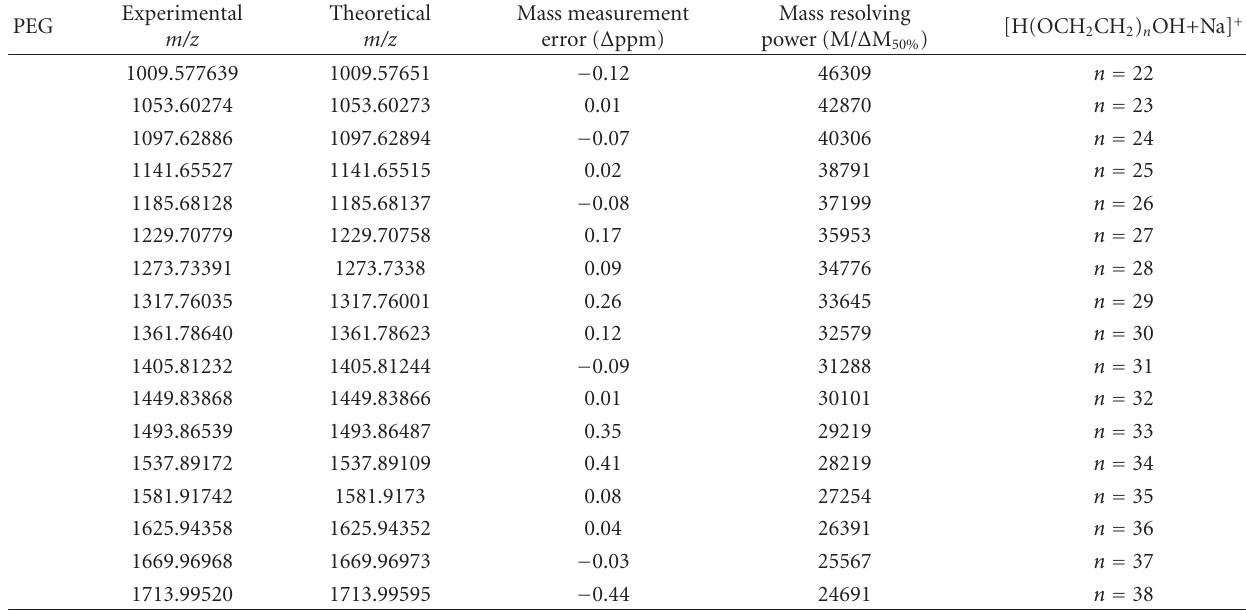
Table 1: PEG standards identified using paper spray mass spectrometry. The PEG mass spectrum was obtained with both an excitation and detection frequency range of 1.5 MHz.